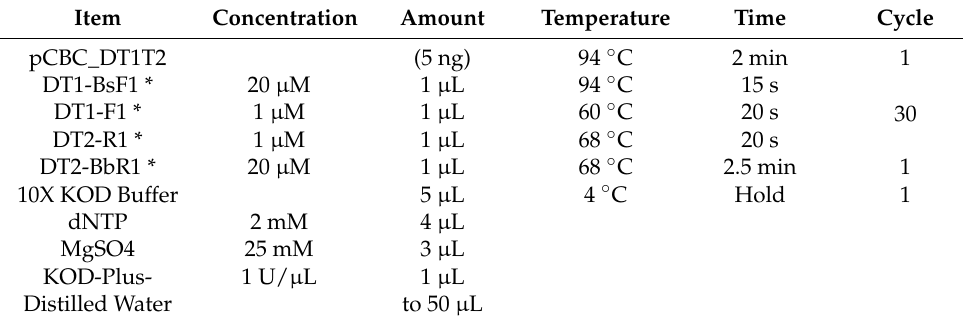
Table 4. PCR components and thermal conditions for the first